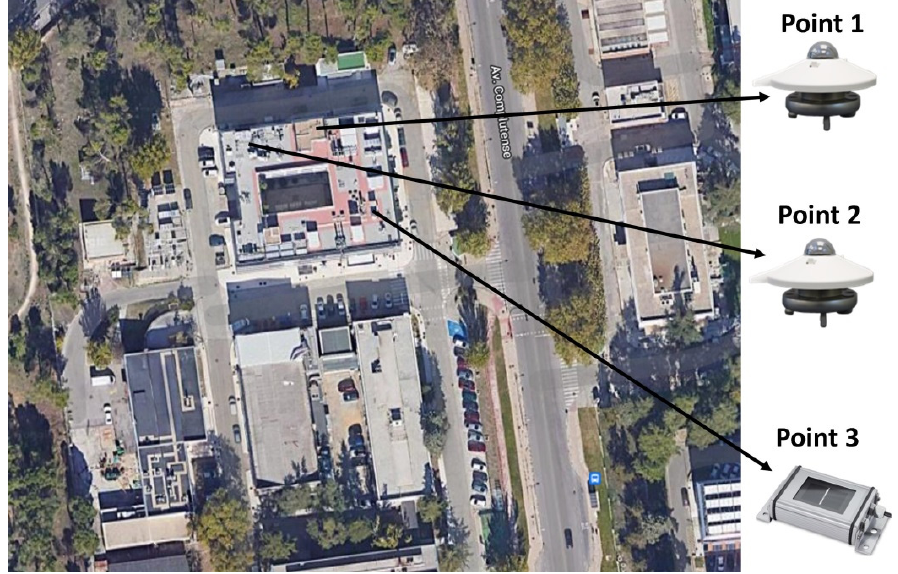
Figure 1. Image of the area under study with the building 42 in the center, including the measuring points placed on the rooftop.